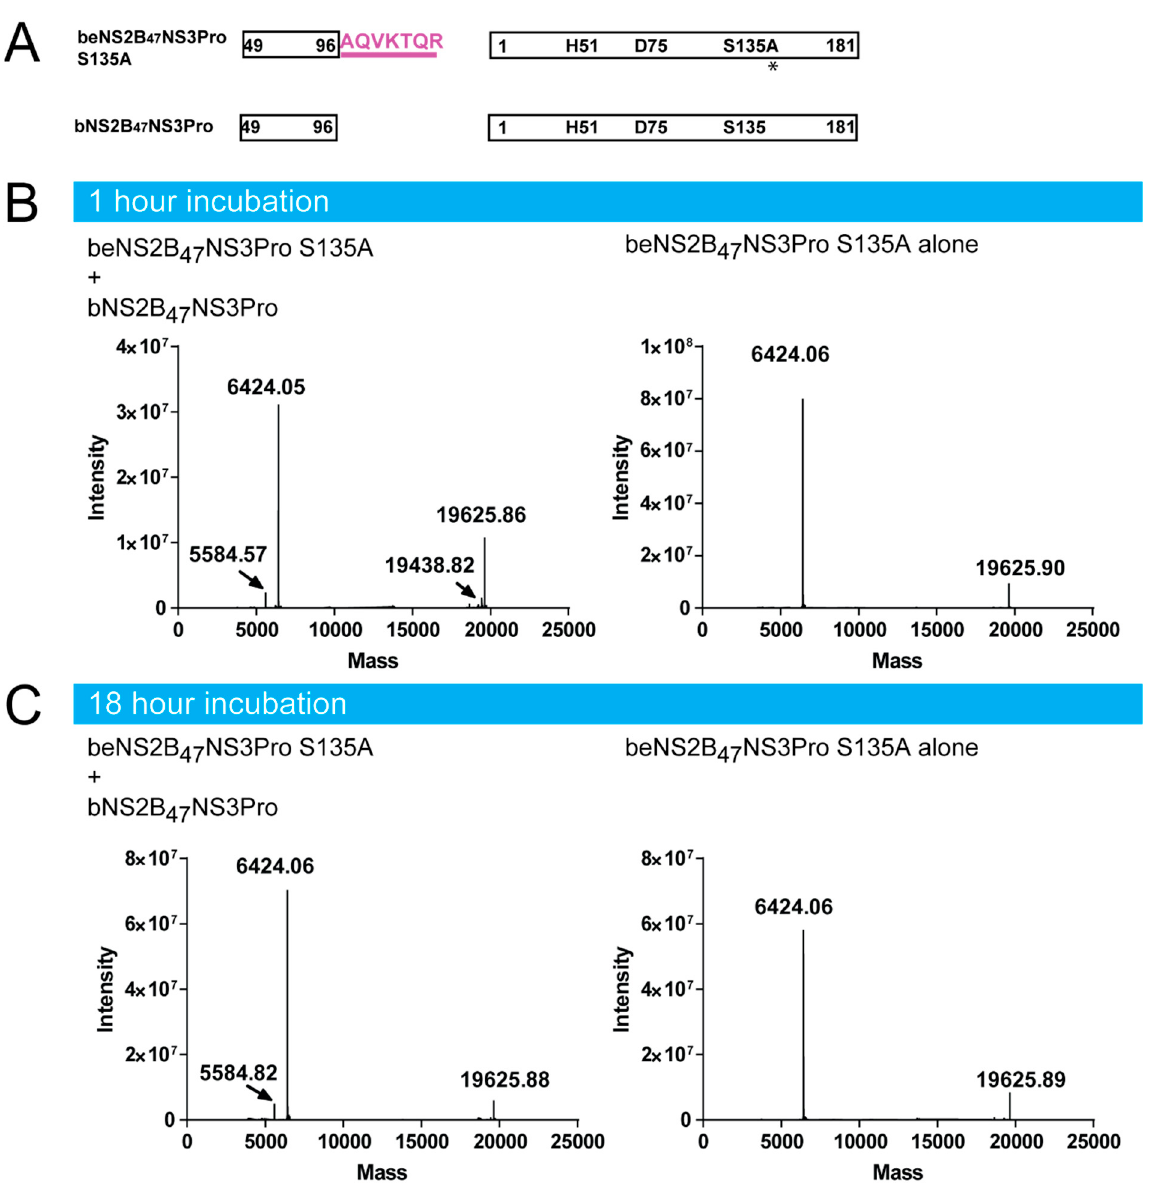
Figure 3. The cleavage between DENV4 NS2B and NS3 occurs in cis. ( A ) Schematic diagram active and unlinked DENV NS2B 47 NS3 Pro constructs. The mutation, S135A, on beNS2B 47 NS3Pro is indicated in asterisk. ( B ) The molecular weight determination of beNS2B 47 NS3Pro S135A with and without active bNS2B 47 NS3 Pro at two-time points ( B ) after 1 h incubation ( C ) after 18 h incubation. The NS2B C-terminus of beNS2B47NS3Pro S135A stays intact even after 18 h of incubation with active unlinked NS3 protease, bNS2B 47 NS3 Pro indicating that the cleavage of NS2B C-terminus is mediated in cis.